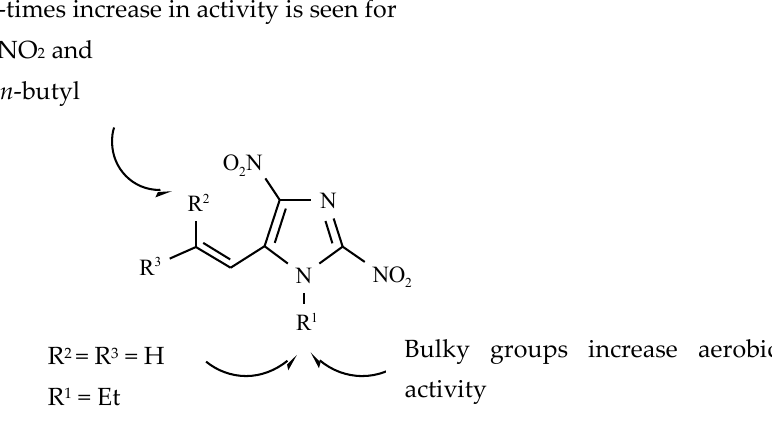
Figure 9. Structure-activity relationships of 2-nitroimidazoles [34].